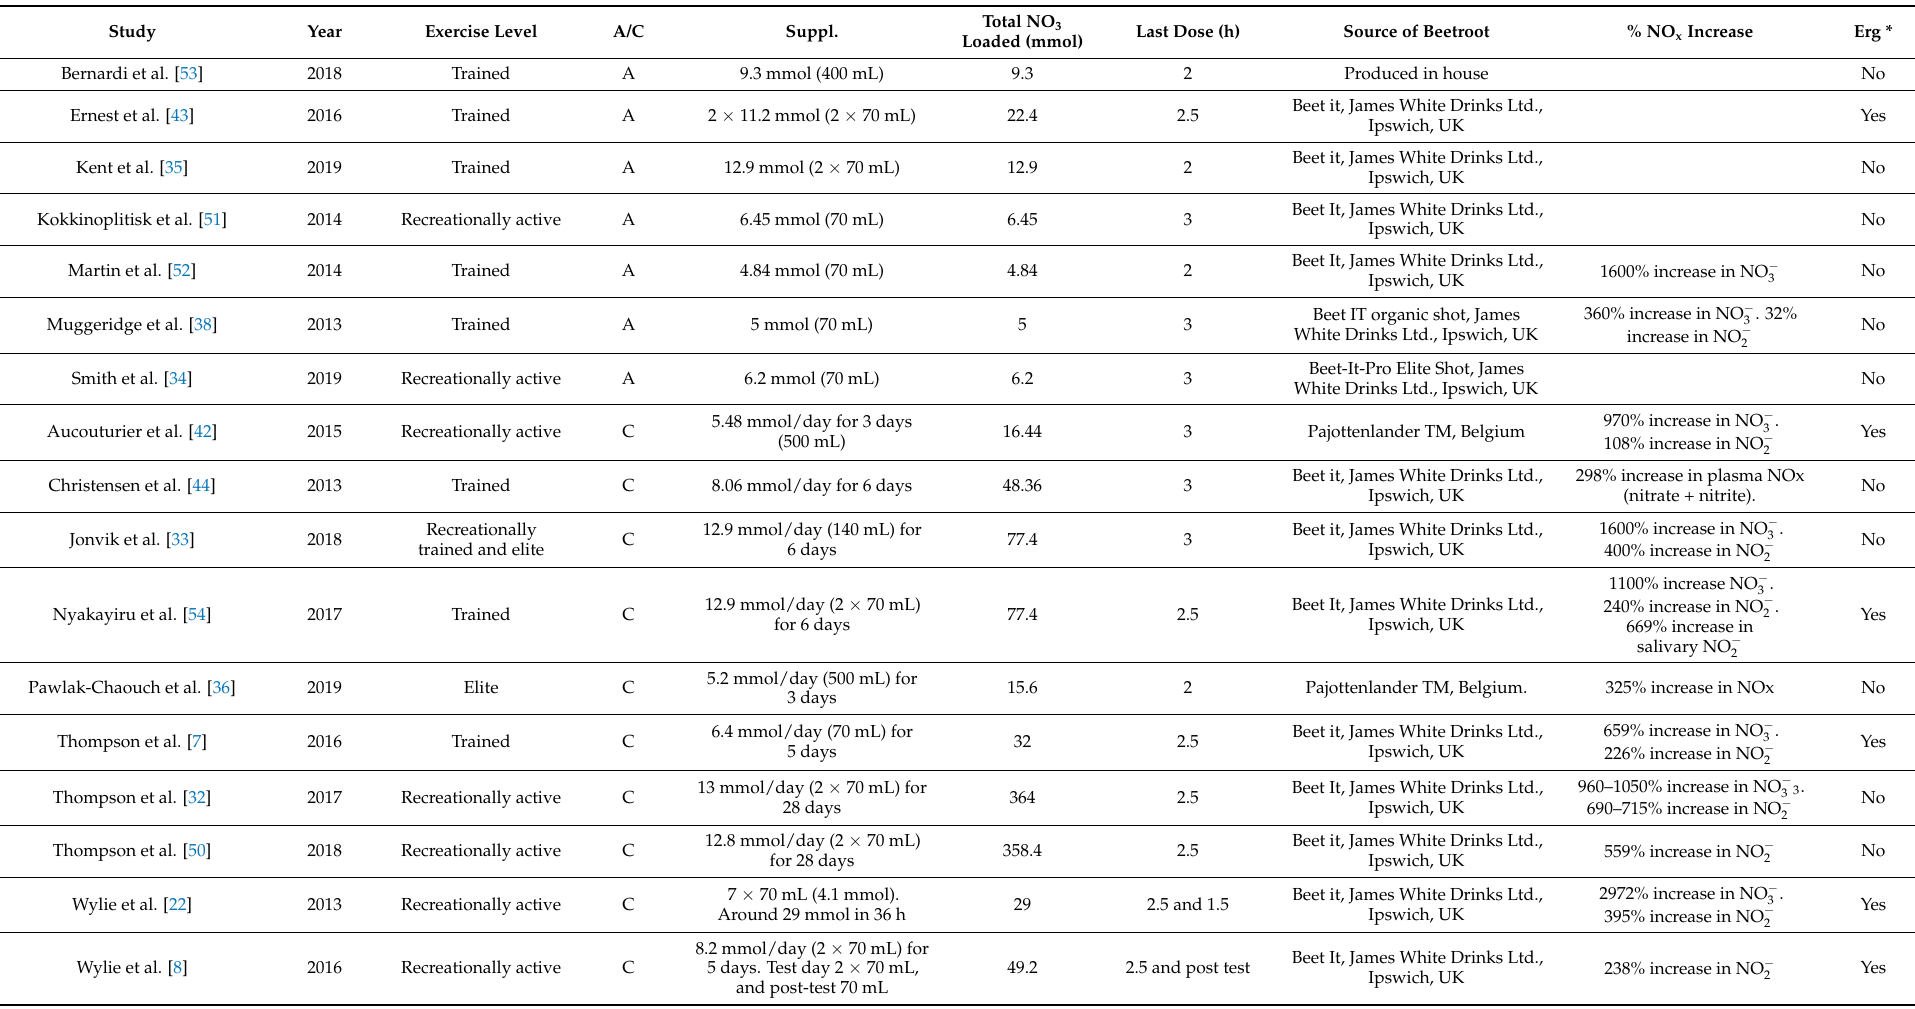
Table 2. Summary of supplementation strategy with sources of beetroot